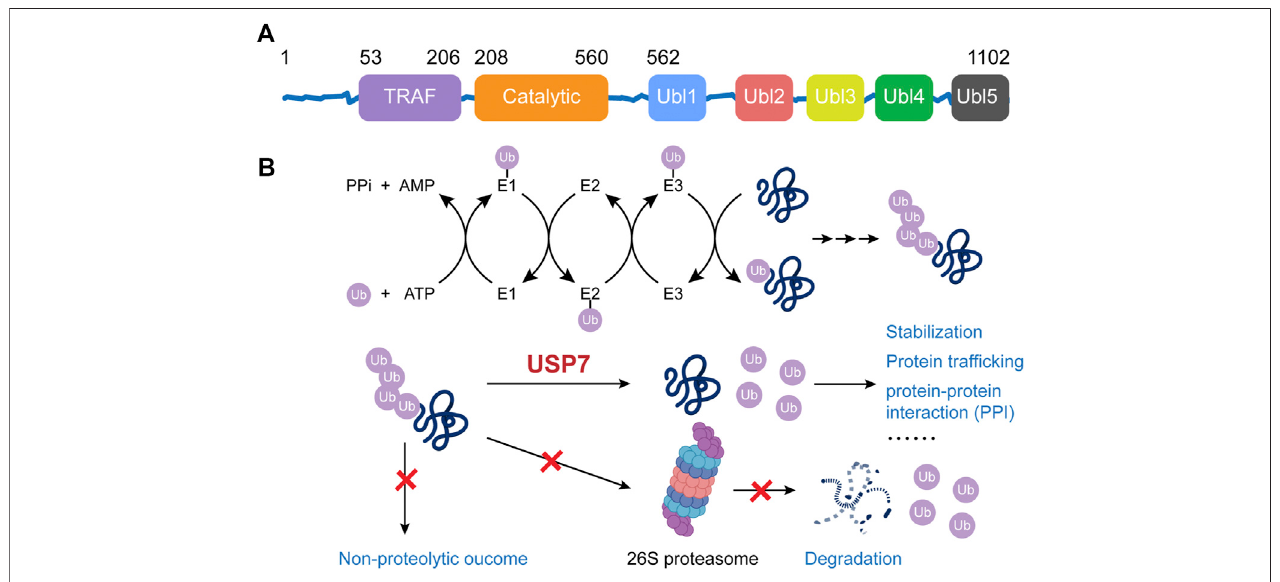
FIGURE 1 | The structure and function of